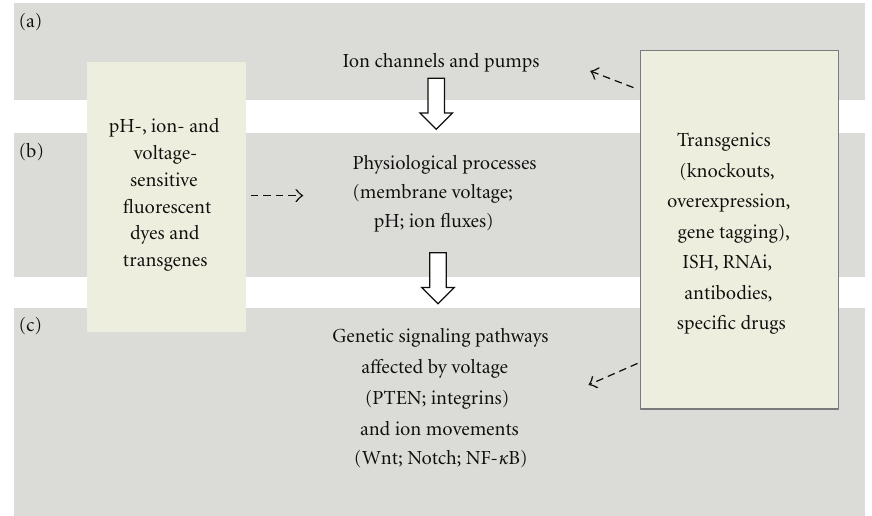
Figure 4: Approaches to study the roles of ion channels in regulation of stem cells in M. lignano. (a) Expression, localization, and function of ion channels and pumps that give rise to bioelectric signals can be addressed in M. lignano by established methods such as RNAi or in situ hybridization (ISH) in combination with specific drugs, antibodies, and transgenics. (b) Changes in ion flows, pH and membrane voltage caused by these channels and pumps can be detected with sensitive fluorescent dyes or followed in vivo in mutants expressing pH- or ion-sensitive forms of fluorescent proteins. (c) These processes a ff ect known (and possibly unknown) genetic signaling pathways via di ff erent mechanisms including changes of Ca 2+ concentrations, voltage-sensing domains of proteins, and voltage-gated transport of signaling molecules. These pathways and functional links between genetic and epigenetic mechanisms of stem cell function regulation can be studied in transgenic mutant lines with the help of RNAi and ISH